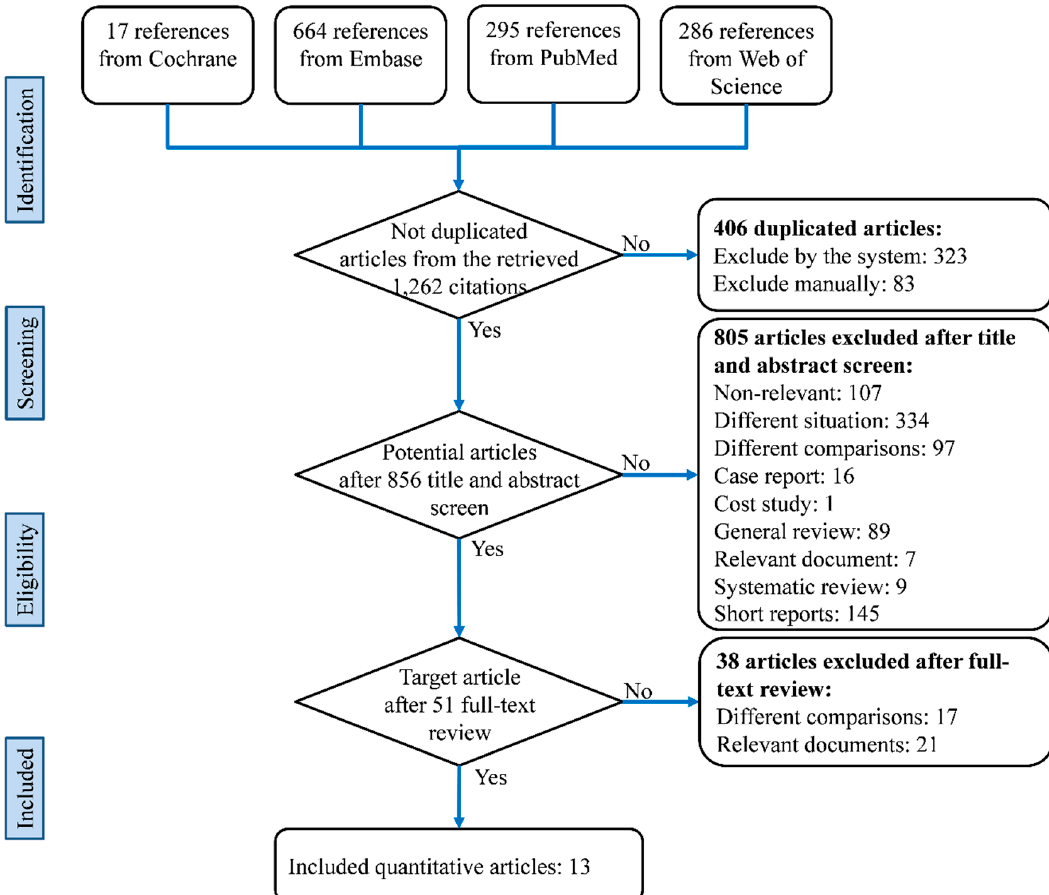
Figure 1. Flowchart of the systematic review and meta-analysis according to the Preferred Reporting Items for Systematic Reviews and Meta-Analyses (PRISMA) guidelines.